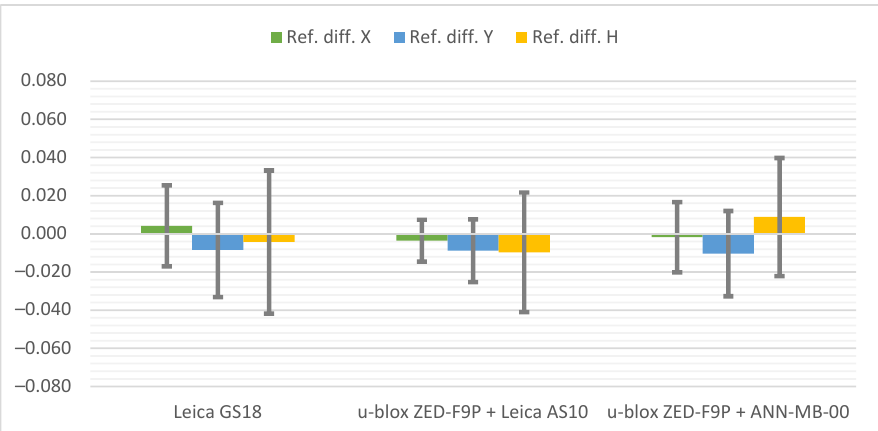
Figure 11. Cumulated diagrams with results of measurements at the Pt 6 station (obscuring the horizon from many directions; differences in relation to the reference points with standard devia- tions